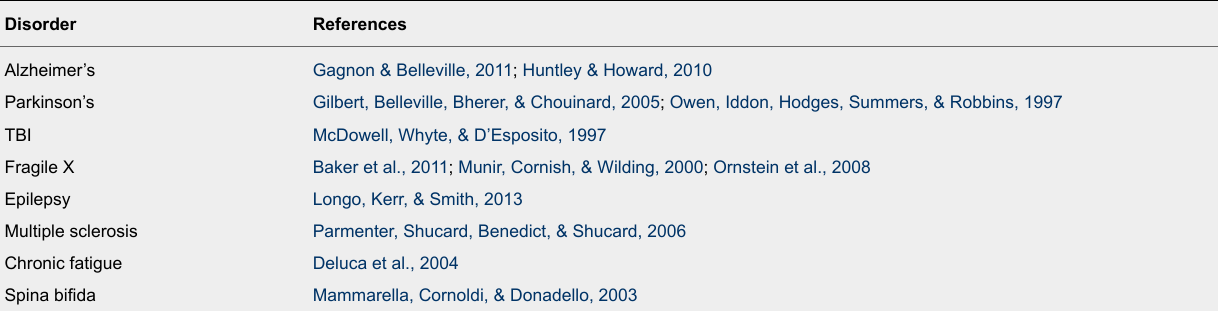
Medical Conditions Associated With Impaired WM